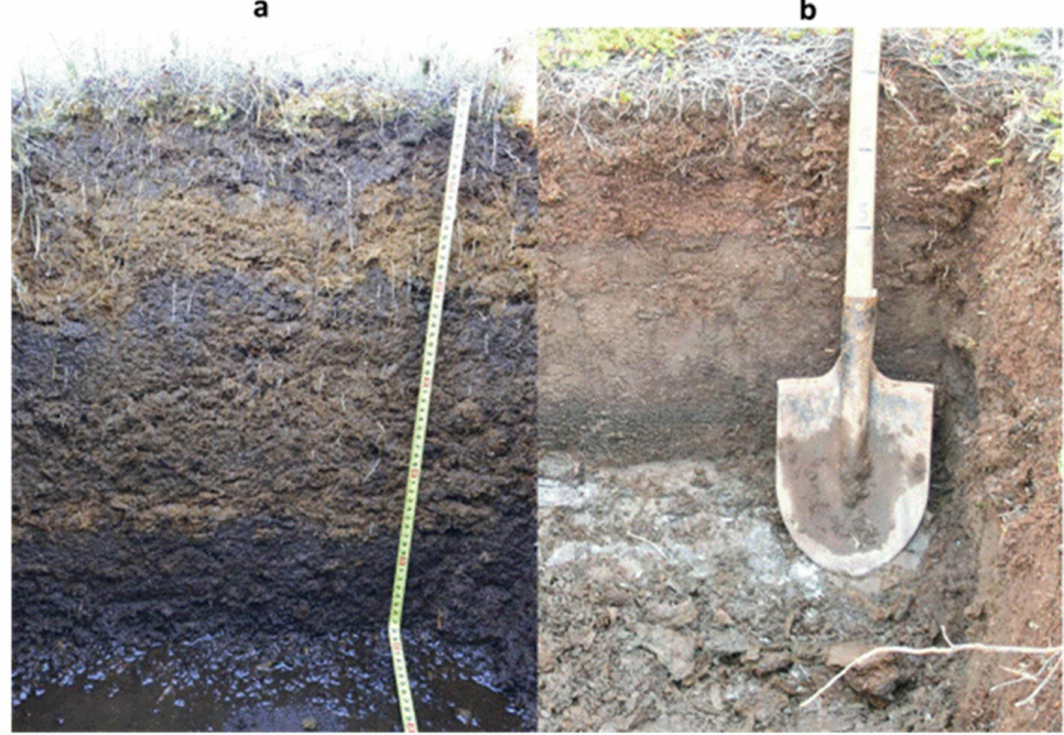
Figure 3. Profiles of ( a ) peat eutrophic cryogenic and ( b ) peaty-humic oligotrophic cryogenic soils. The botanical composition of peat plant residuals, as well as the ash contents of deposits vary depending on the site. On the slopes of tundra spurs, green moss and cotton grassroots residuals dominate compositions of the organic horizon, providing a specific rigid inherent structure of its substrate. The hummocky tundra bogs’ peat has a sedge and mixed moss composition with a higher share of residuals of the dwarf shrub stems and roots. The hummock-ridge tundra sphagnum-sedge peat bogs lie at the slopes’ feet. Sections with sheet (laminated) peats with various component compositions (moss, herb, and willow) can also be found there (see Figure